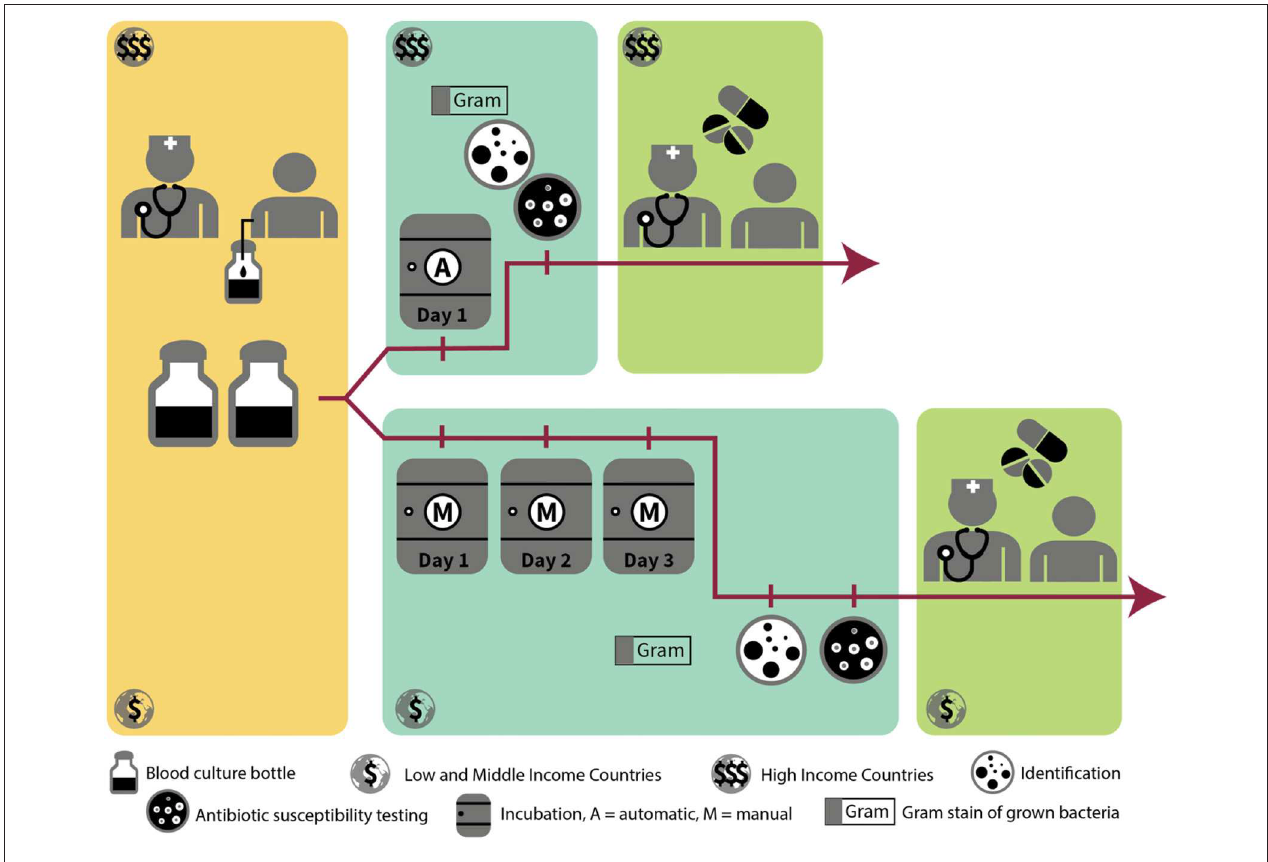
FIGURE 1 | Workflow of grown blood cultures in high-resource vs. low-resource